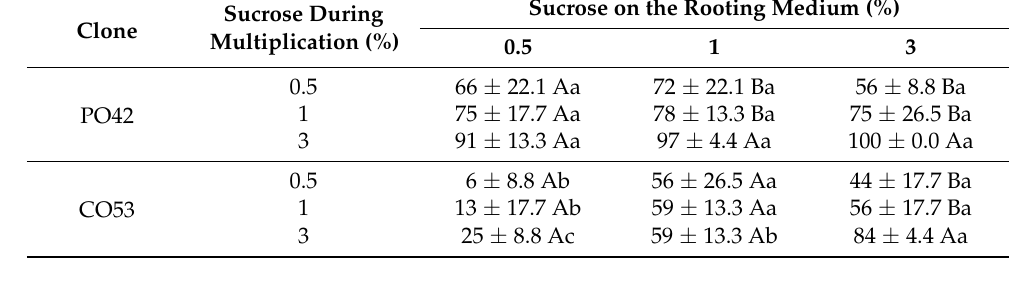
Table 1. Effect of sucrose supplementation on the rooting percentage of chestnut. Shoots of clones PO42 and CO53 were cultured by temporary and continuous immersion with 0.5, 1 and 3% sucrose. Shoots from each sucrose treatment during the multiplication phase were distributed between 0.5, 1 and 3% sucrose treatments during the rooting expression phase. Means ± standard error were calculated from 2 replicates, each with 16 shoots per treatment. For each clone, different uppercase letters within a column indicate significant differences regarding sucrose concentration during multiplication, and different lowercase letters within a row indicate significant differences regarding sucrose concentration during rooting expression (Pearson’s Chi-square test, p < 0.05). Sucrose on the Rooting Medium (%) Sucrose During Clone Multiplication (%) 0.5 1 3 0.5 PO42